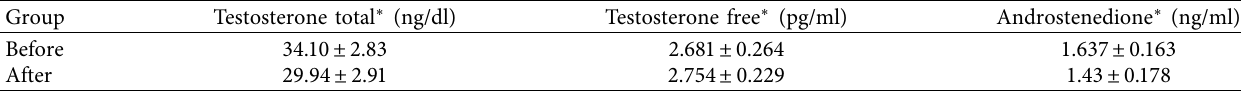
Table 4: The endocrine and metabolic assessment of patients before and after the treatment with Tracnil ™ . Group Testosterone total ∗ (ng/dl) Testosterone free ∗ (pg/ml) Androstenedione ∗ (ng/ml) Before 34.10 ± 2.83 2.681 ± 0.264 1.637 ± 0.163 After 29.94 ± 2.91 2.754 ± 0.229 1.43 ± 0.178